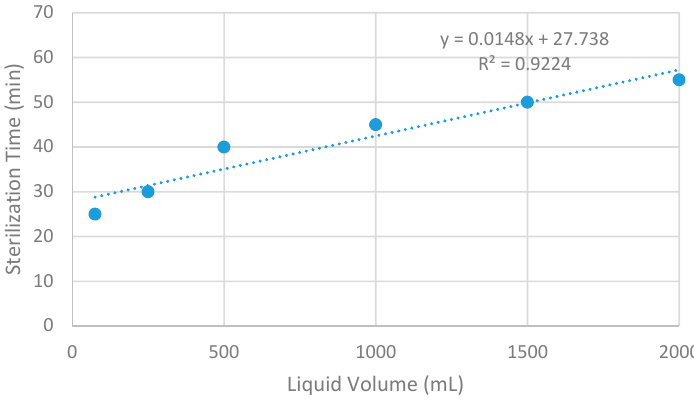
Figure 1. Required sterilization time as affected by liquid volume using an autoclave at 121 °C and 1.0 atmospheres (15 psi gage) pressure (data from Reference [12]).